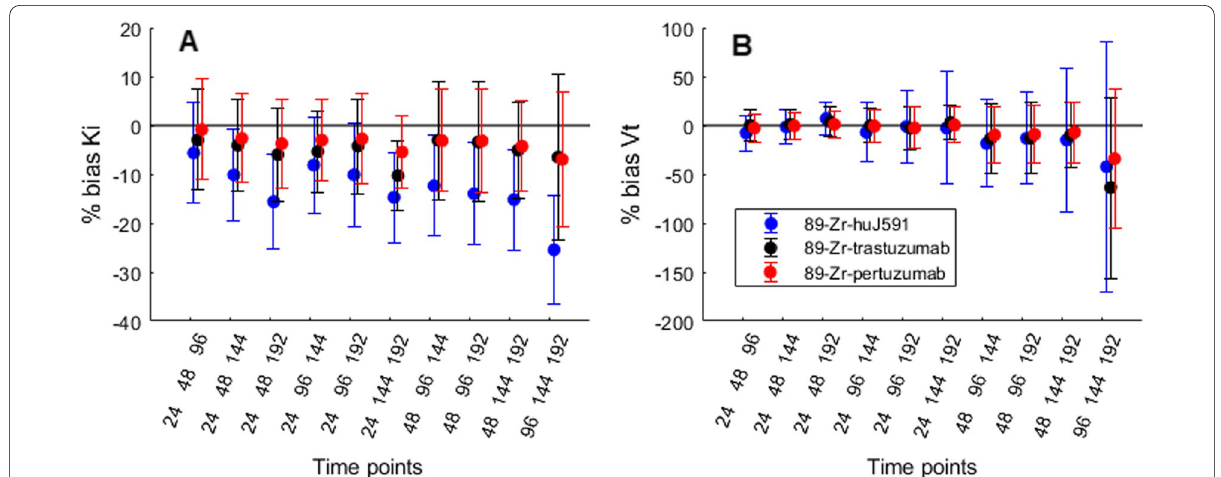
Fig. 3 Percentage bias and variability of K i ( A ) and V T ( B ) per time point combination, for 89 Zr‑huJ591, 89 Zr‑trastuzumab and 89 Zr‑pertuzumab input functions and time activity curves with 5% noise, rK i and variability than combinations without 24 h p.i. rK i